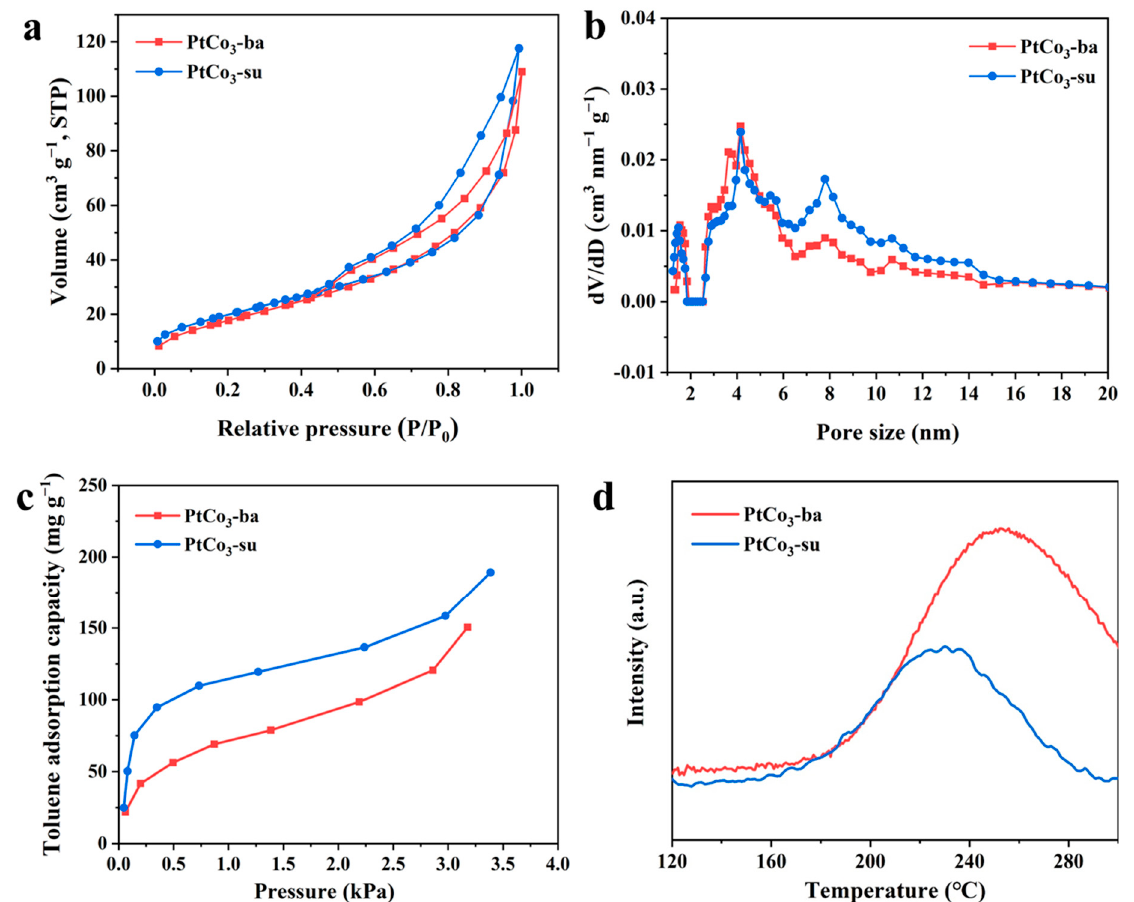
Figure 7. N 2 adsorption and desorption ( a ), pore size distribution ( b ), toluene adsorption isotherms ( c ), and C 7 H 8 -TPD profiles ( d ) of catalysts.